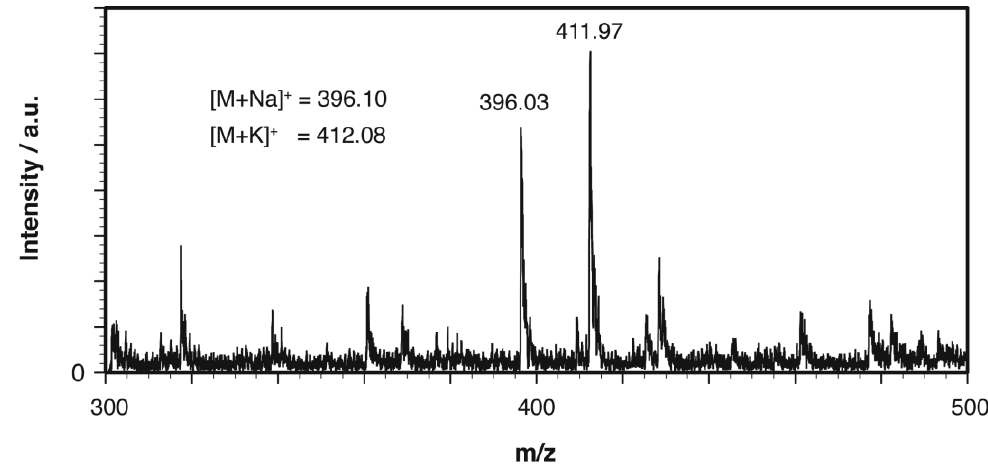
Figure 2. MALDI-TOF-MS spectrum of the hydrolysate after the